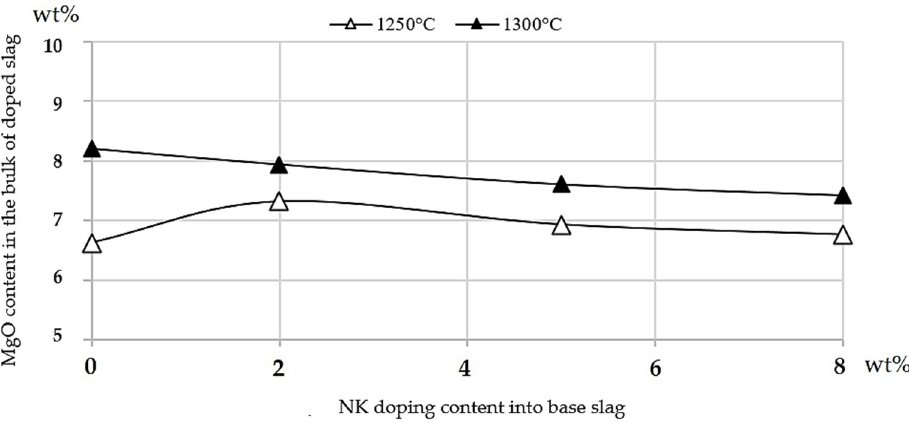
Figure 10. Magnesia content in the bulk of the doped slag v/s the initial natural kaolinite (NK) doping content, measured by XRD-WPPF.